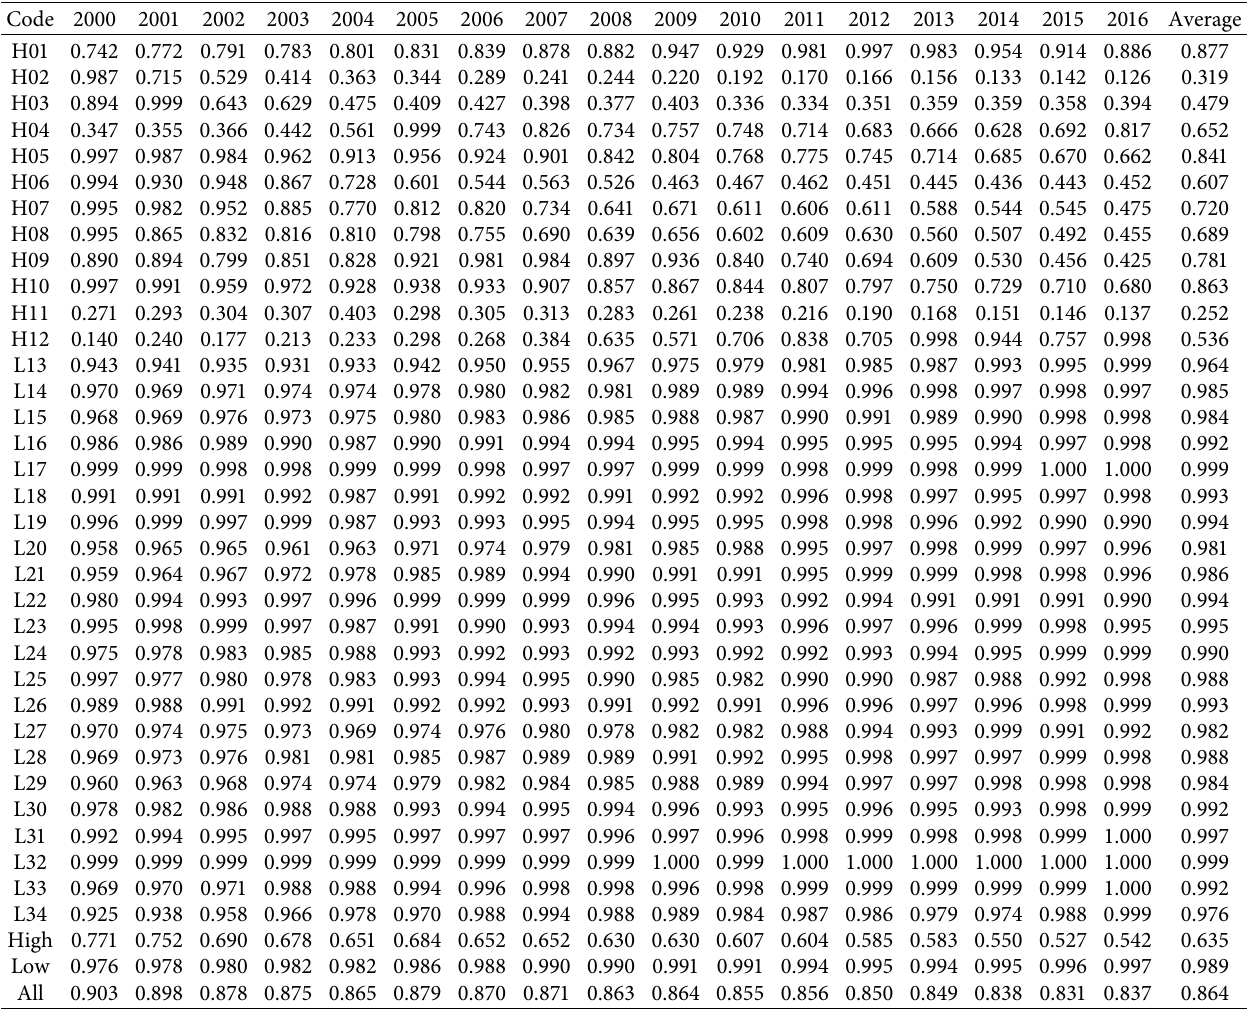
Table 5: Metafrontier ratio of China’s industrial